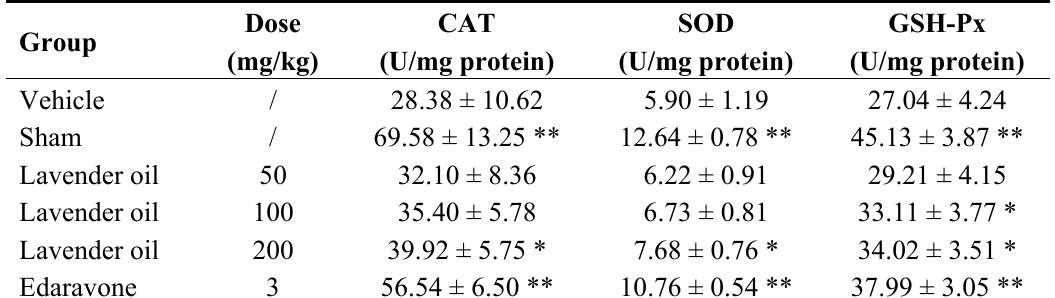
Table 2. Effects of lavender oil and edaravone on the antioxidant enzyme activities after 22 h of